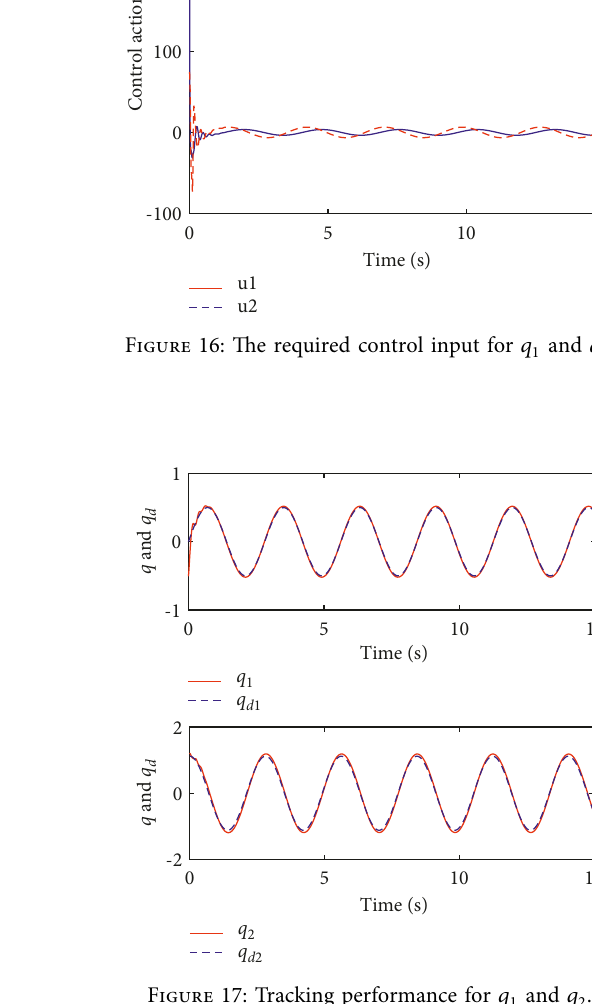
Figure 17: Tracking performance for q